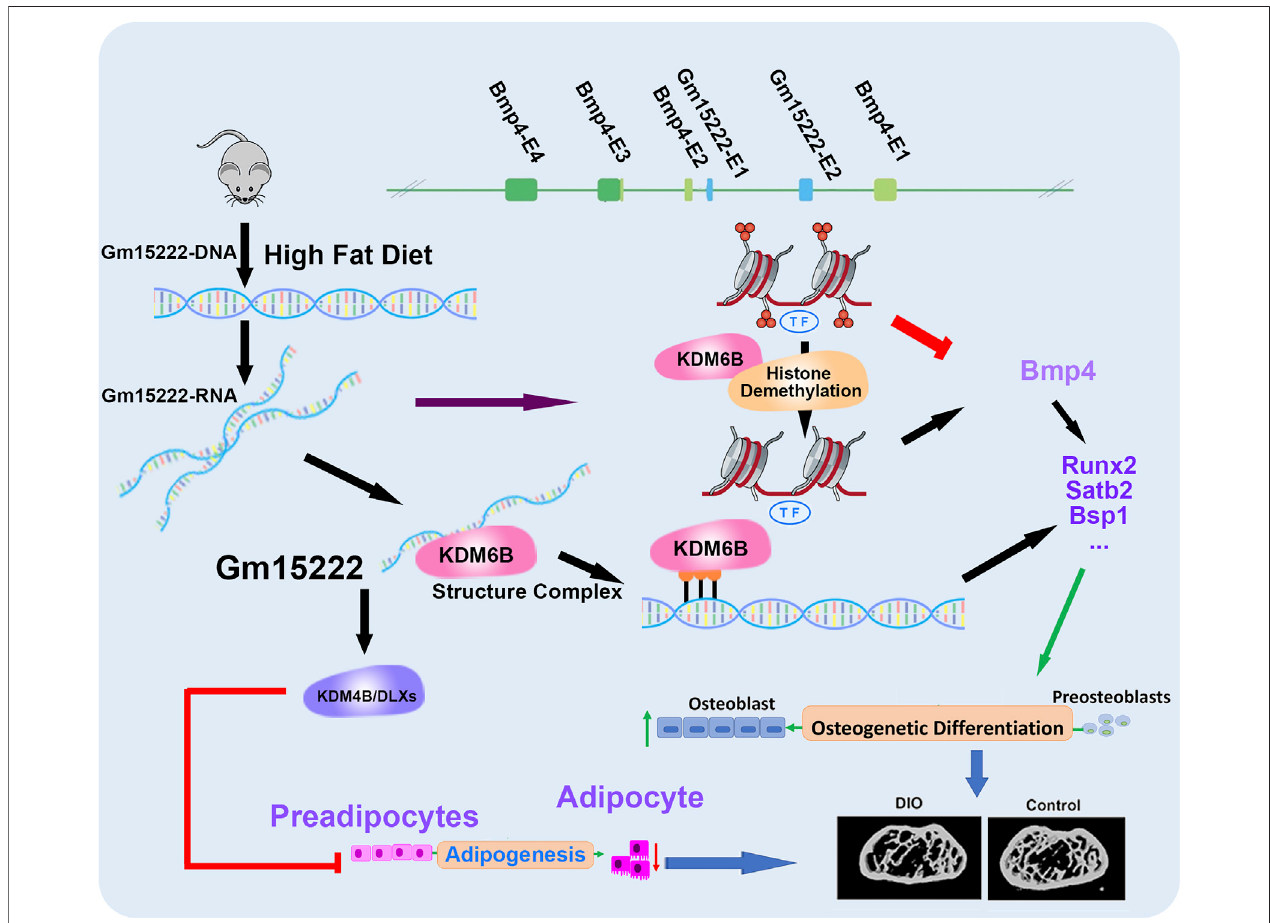
FIGURE 6 | A schematic diagram showing our newly identi fi ed Gm15222 and the epigenetic mechanisms and potential of how Gm15222 targets the pathophysiology of diabetic bone disease (DBD). In detail, Bmp4 contains four exons (E1-E4), and Gm15222 contains two exons (E1-E2). lnR-Gm15222 can recruit KDM6B and reducing the modi fi cation of H3K27me3, thereby leading to the expression of osteogenic genes; meanwhile, to overcome the adipogenesis, Gm15222 might participate the KDM4B associated adipogenic inhibition.